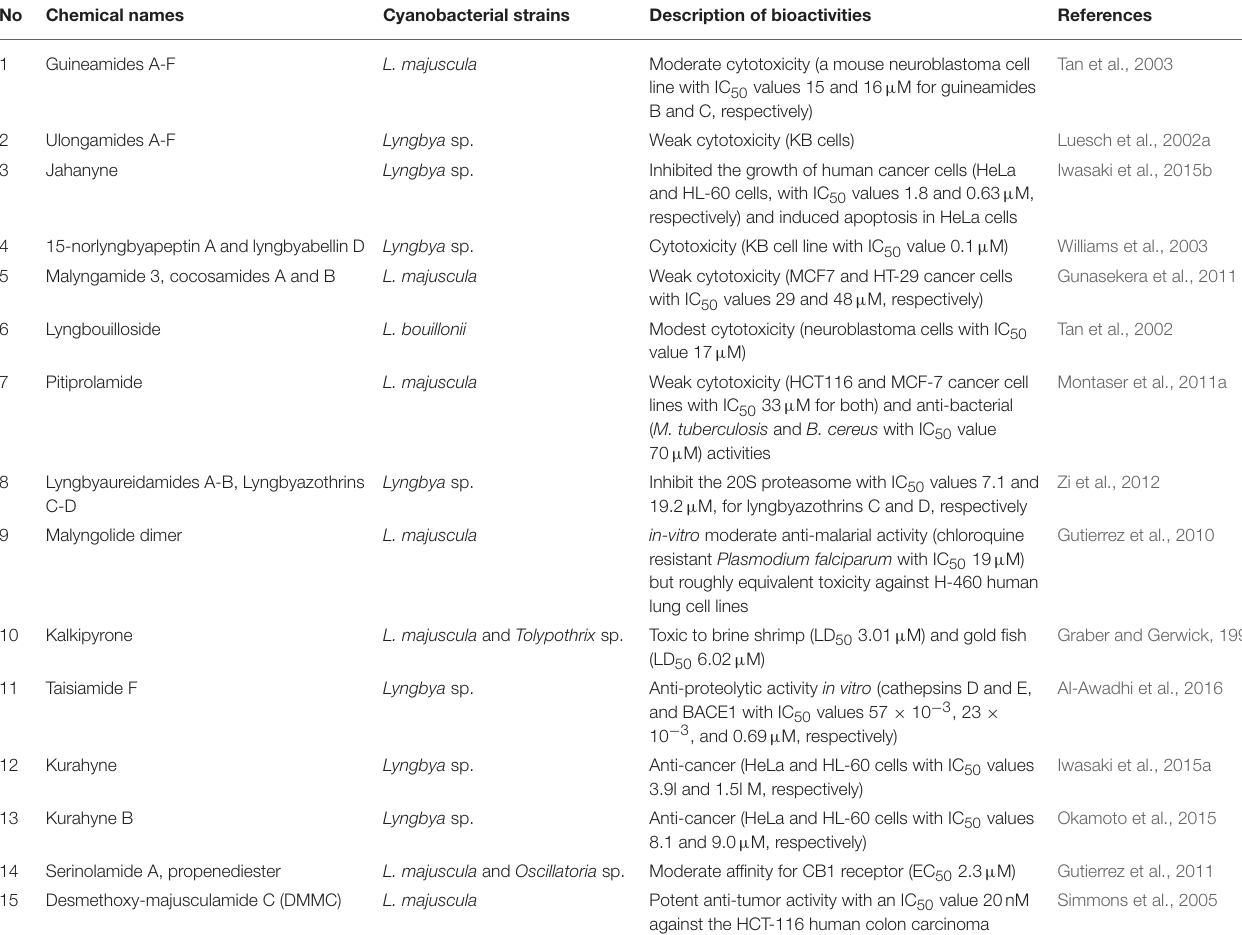
TABLE 2 | Lists of compounds from Lyngbya and biological